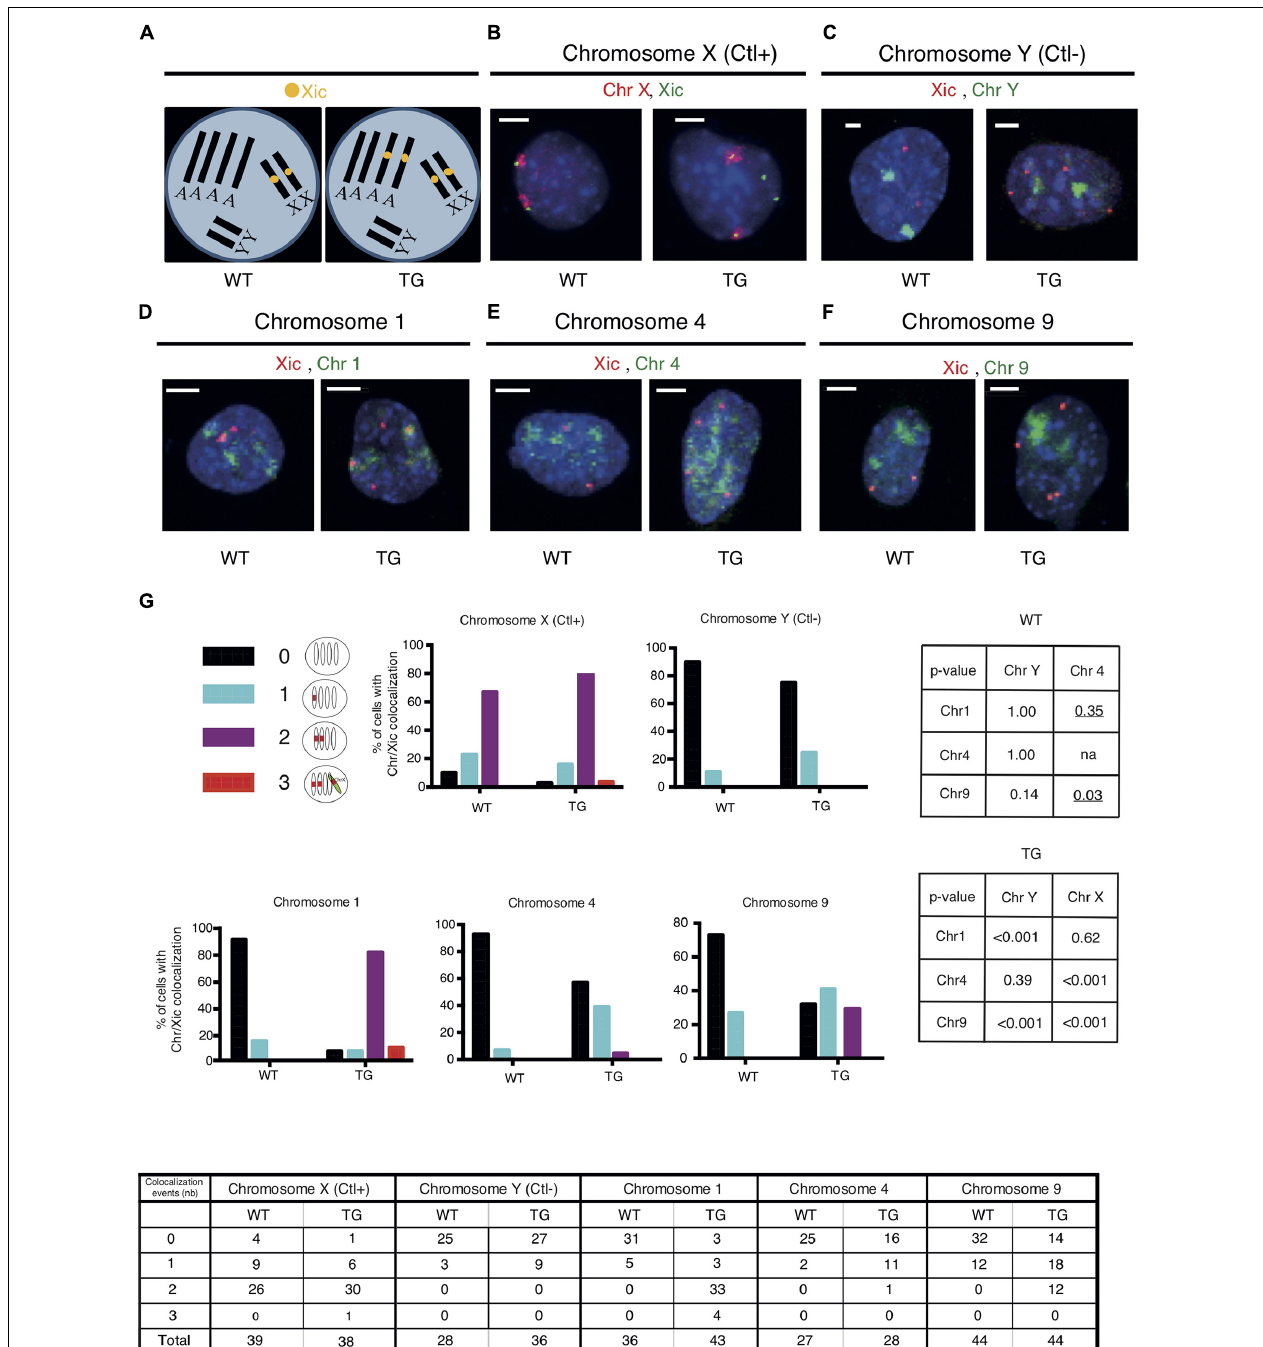
FIGURE 2 | The Xic transgene co-localizes with chromosome 1 in TG male fibroblasts. (A) DNA FISH patterns are shown for Xic signals in WT and TG male TTFs with tetraploid chromosomes. There are four copies of each autosome and two copies of each sex chromosome. In WT cells, there are two copies of Xic signals corresponding to the endogenous Xic ; in TG cells, a total of four Xic signals are present with two for the endogenous Xic and two for the Xic transgenes. (B–F) Dual-color DNA FISH was performed using chromosome paints in combination with Xic probes as indicated for WT and TG cells. Chromosome X was used as a positive control (Ctl+) for the endogenous Xic co-localizing with the X chromosome in both WT and TG cells; chromosome Y was used as a negative control (Ctl-) for the absence of co-localization between Xic and the Y chromosome in both WT and TG cells. Representative images are shown; the scale bar is 5 µ m in length. (G) Summary of co-localization patterns and events. Numbers of co-localizations between Xic and chromosome paint signals within a cell nucleus are illustrated. Histograms depicting the percentage of cells with detected co-localization events are shown. P -values are shown in the tables for pairwise comparisons performed by Fisher’s Exact Test on the co-localization events in WT and TG samples: two-tailed p -values were used across all comparisons except where one-tailed p -values (underlined) were used when testing any increase of co-localization in the comparisons to Chr 4; na, not applicable. Cell numbers are listed in the chart.